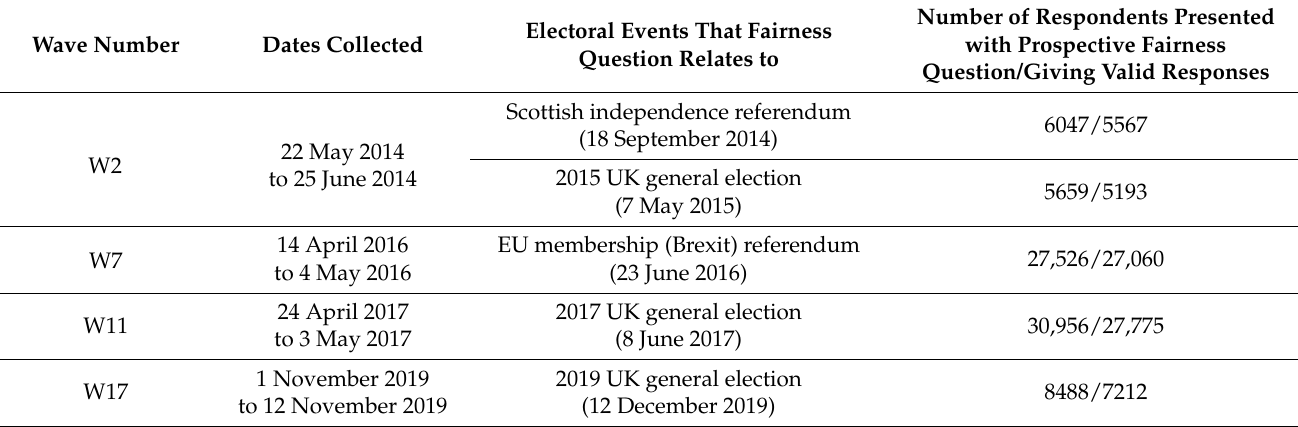
Table 1. British Election Study Internet Panel waves